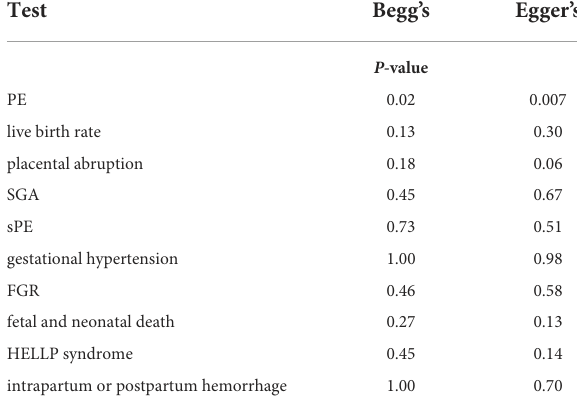
TABLE 2 Results of Egger’s and Begg’s